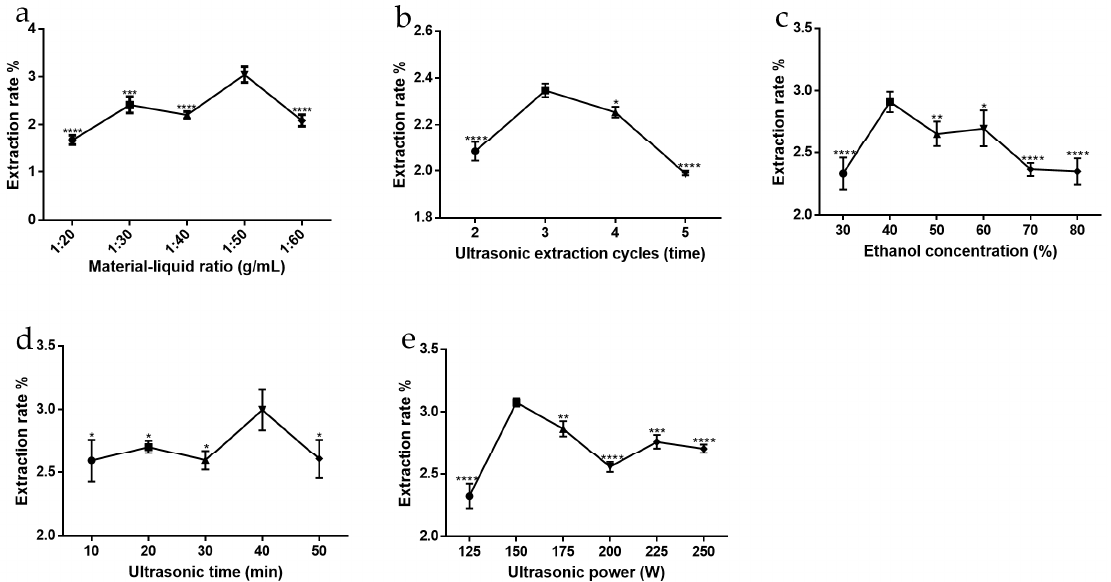
Figure 1. Effect of single factors on the total flavonoid extraction yield from Abrus cantoniensis. ( a ) Material-liquid ratio, ( b ) ultrasonic extraction cycles, ( c ) ethanol concentration, ( d ) ultrasonic time, ( e ) ultrasonic power. Data are expressed as mean ± SD ( n = 3). * p < 0.05, ** p < 0.01, *** p < 0.001 and **** p < 0.0001 compared with the highest point in each group.